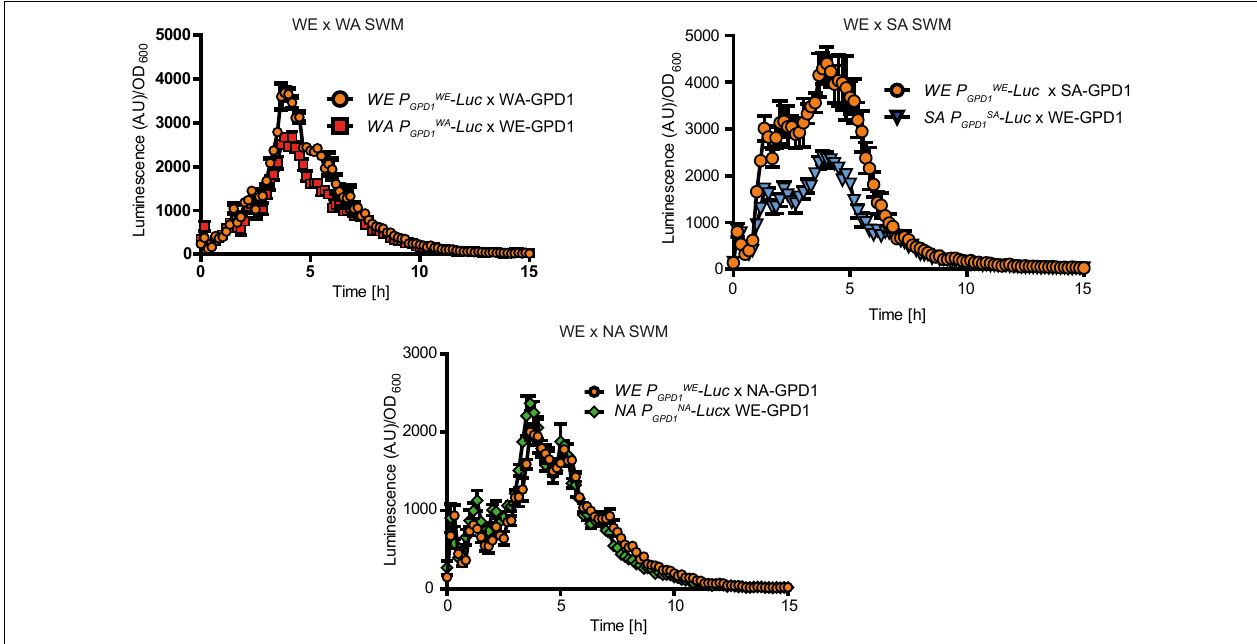
FIGURE 4 | Luciferase reporter assay in GPD1 reciprocal hemizygotes. Luminescence levels in GPD1 WE × WA, WE × SA, and WE × NA hemizygotes in micro cultivation in